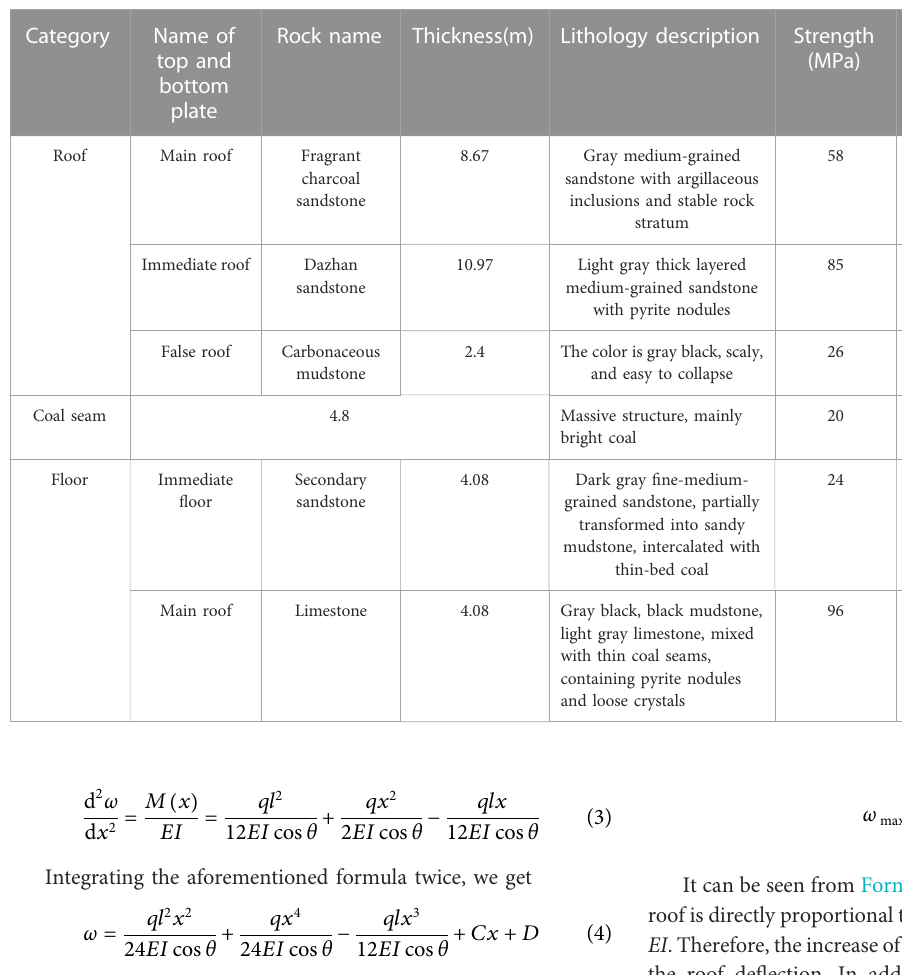
TABLE 1 Rock mass on roof and fl oor of coal